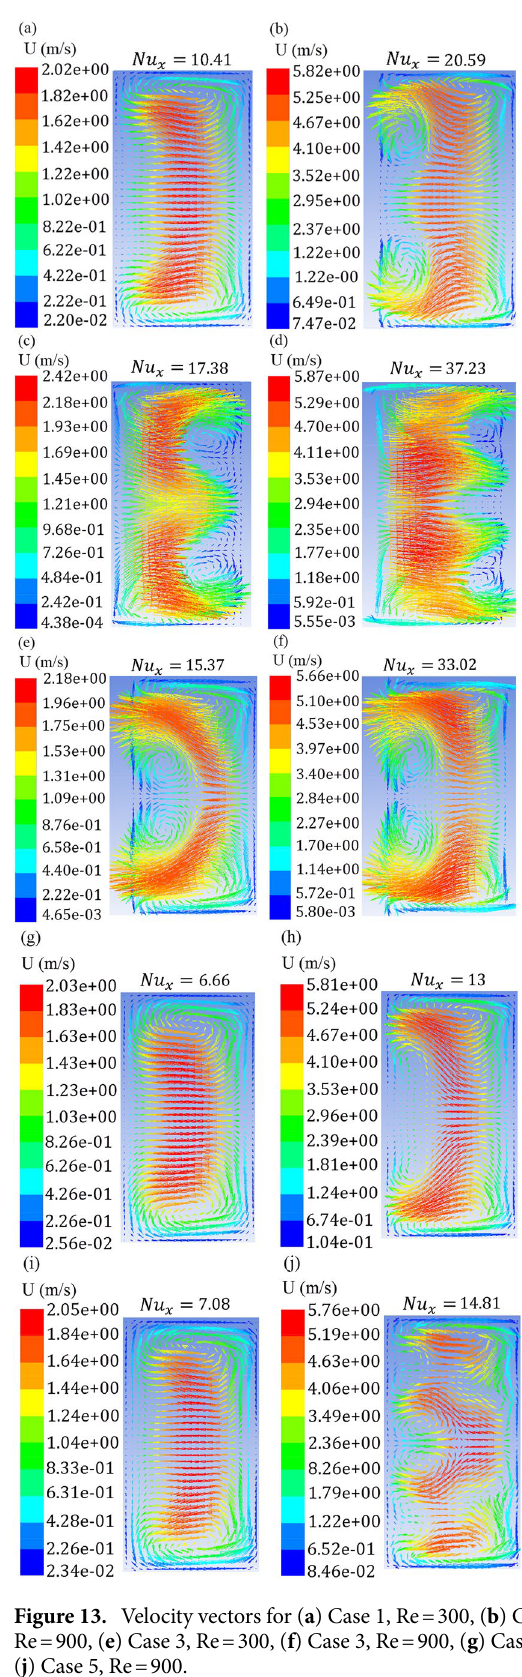
Figure 13. Velocity vectors for ( a ) Case 1, Re = 300, ( b ) Case 1, Re = 900, ( c ) Case 2, Re = 300, ( d ) Case 2, Re = 900, ( e ) Case 3, Re = 300, ( f ) Case 3, Re = 900, ( g ) Case 4, Re = 300, ( h ) Case 4, Re = 900, ( i ) Case 5, Re = 300, ( j ) Case 5, Re =